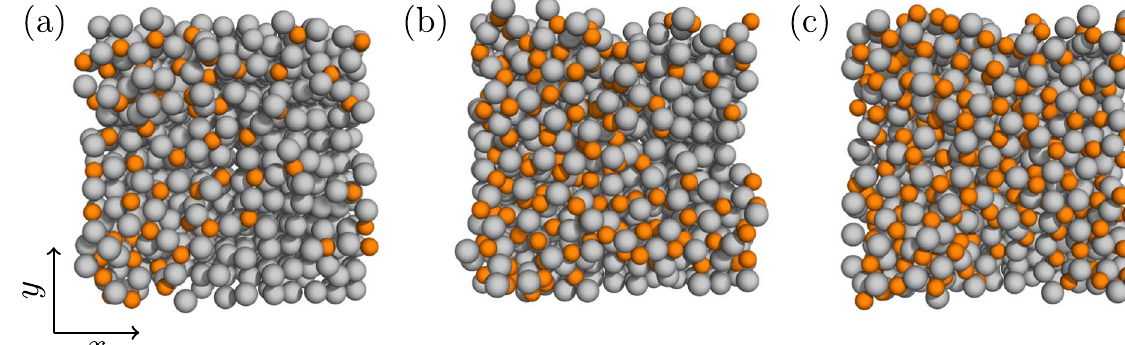
Fig. 8 Formation and fi lling of a hole in the oxide. Formation and fi lling of a hole in the oxide during the oxidation process, showing snapshots after the addition of ( a ) 60, ( b ) 120 and ( c ) 180 oxygen atoms. A hole is observed to form and then close during the oxidation of a 24 × 24 Å 2 substrate. This calculation was performed with the S – M potential.